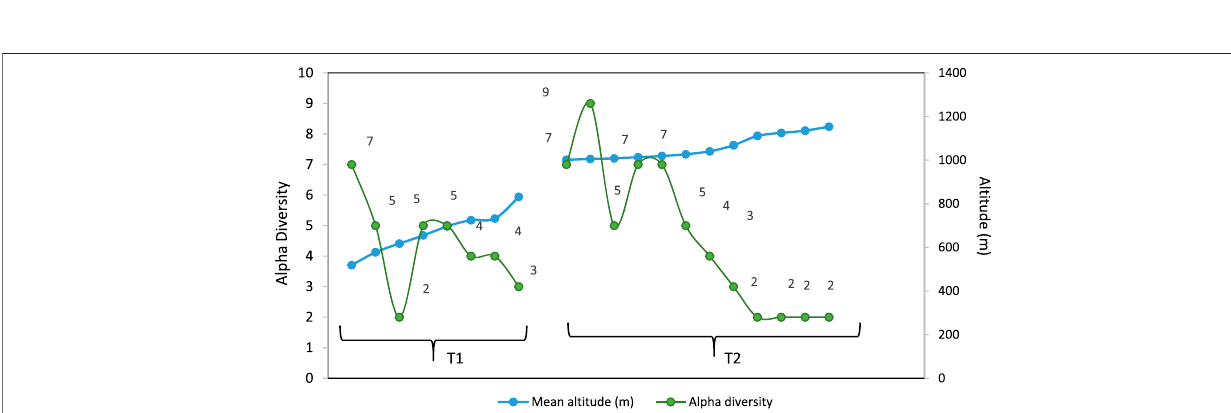
FIGURE 8 | Variations of alpha diversity in the T1 and T2 river sections.